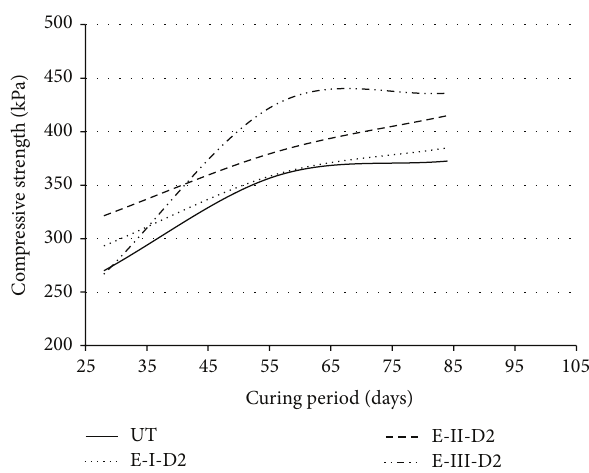
Figure 6: Variations in UCS for untreated (UT) and treated (double dosage) soil